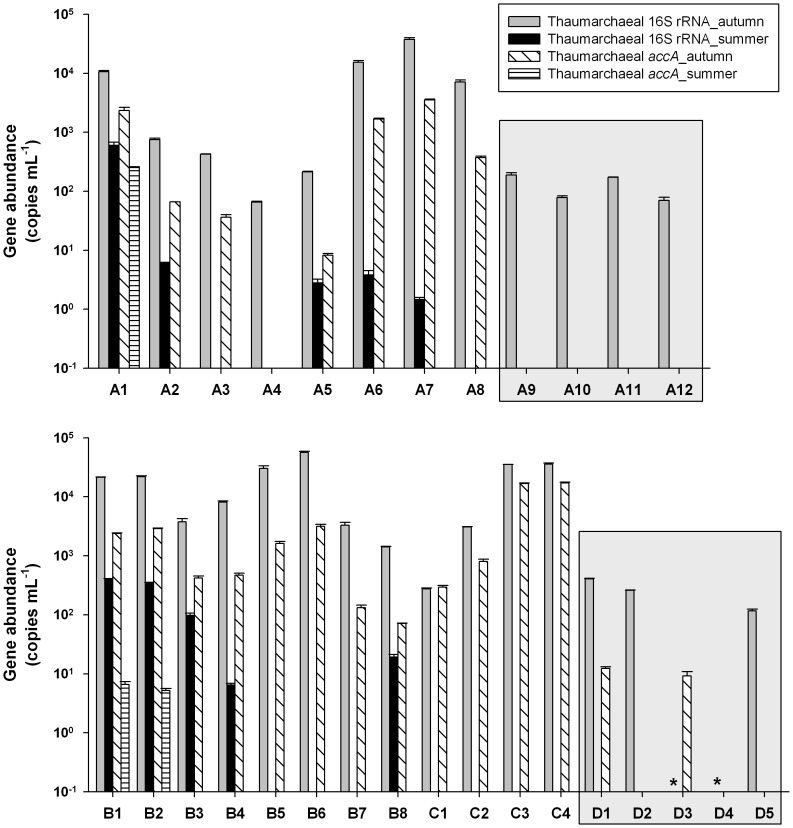
Surface distribution of the abundance of thaumarchaeal 16S rRNA and accA genes in the ECS.Bars denote one standard deviation of the triplicate qPCR determination. Asterisks indicate that abundance of thaumarchaeal 16S rRNA gene was not determined in stations D3 and D4 since there was not enough environmental DNA. Surface water samples were only collected in autumn of 2007 (grey shaded area).